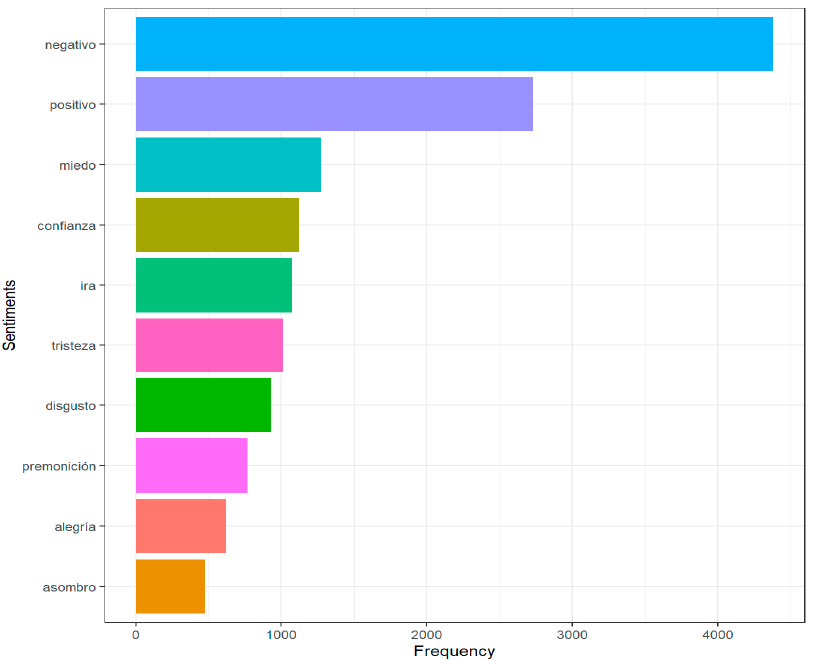
Figure 5. The most frequently used terms.